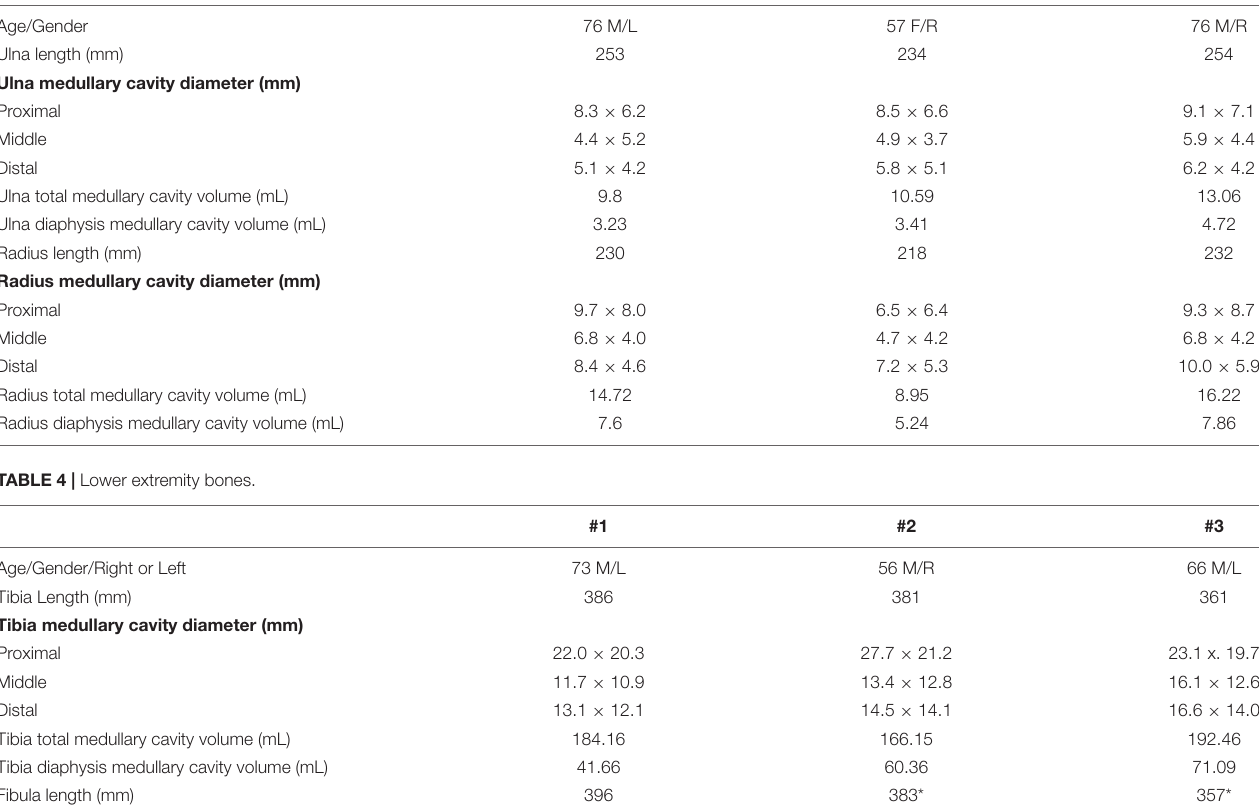
TABLE 3 | Upper extremity bones.